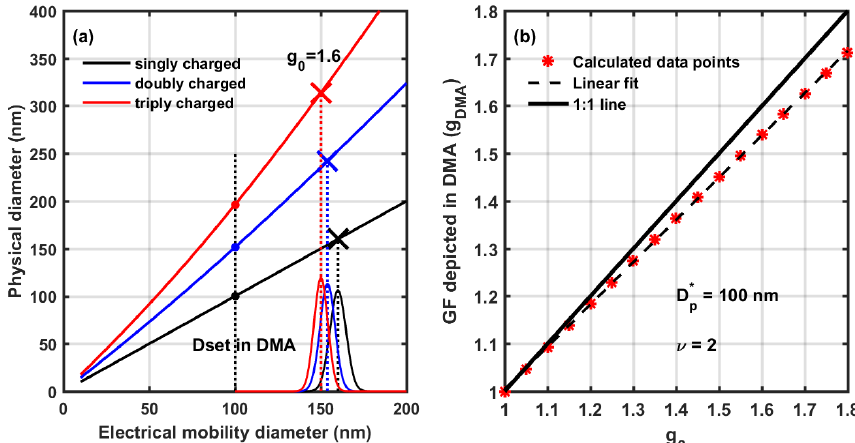
Figure 2. (a) Effects of multiply charged particles on the growth factor. The black, blue, and red lines represent singly, doubly, and triply charged particles, respectively. The circles represent particles selected by the DMA when the electrical mobility diameter is set to 100nm. When the true growth factor is 1.6, these particles grow to the diameters represented by the corresponding crosses. The mode of the MDF of multiply charged particles peaks at a smaller GF than the true value. (b) The compression effect on the growth factor for doubly charged particles with an electrical mobility diameter of 100nm.